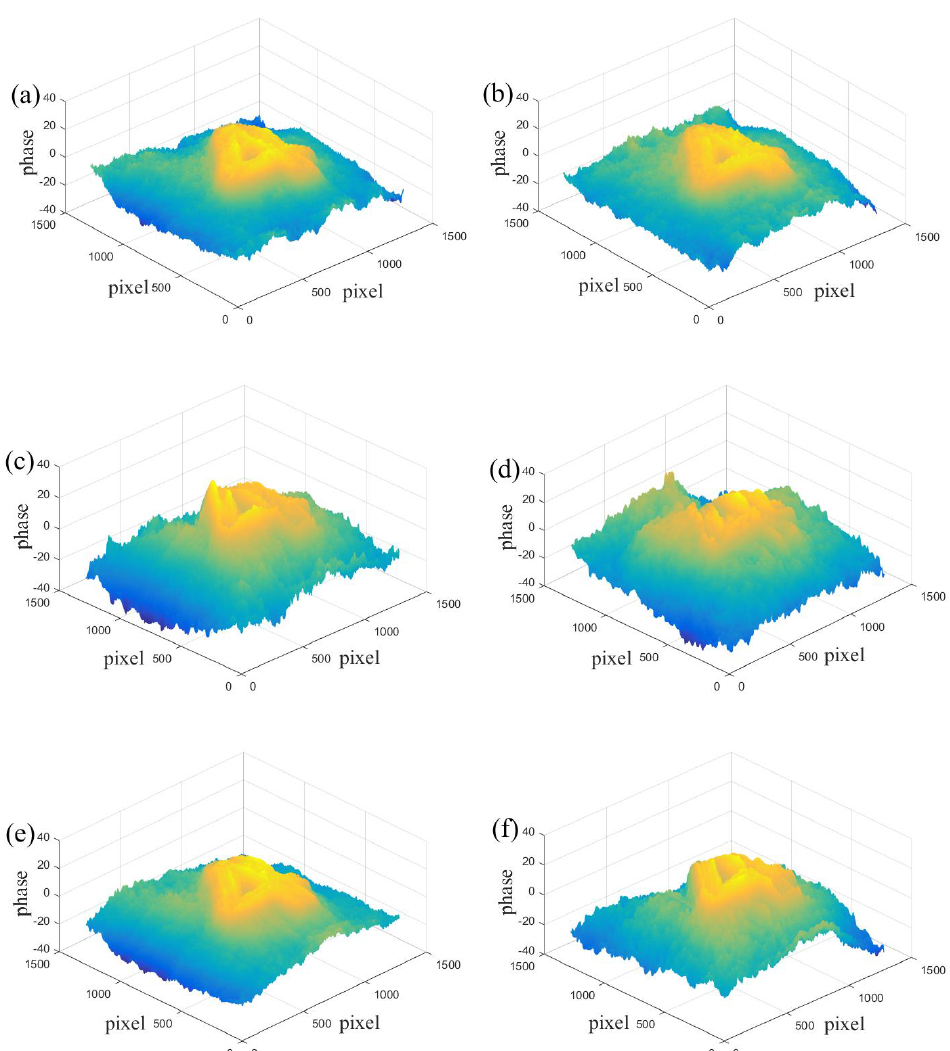
Figure 10. Reconstructions of the phase with different spatial filtering methods: ( a ) PSFM, speckle noise with a mean 0 and variance of 0.02; ( b ) PSFM, speckle noise with a mean of 0 and variance of 0.04; ( c ) RGFM, speckle noise with a mean of 0 and variance of 0.02; ( d ) RGFM, speckle noise with a mean of 0 and variance of 0.04; ( e ) ITFM, speckle noise with a mean of 0 and variance of 0.02; ( f ) PSFM, speckle noise with a mean of 0 and variance of 0.04.